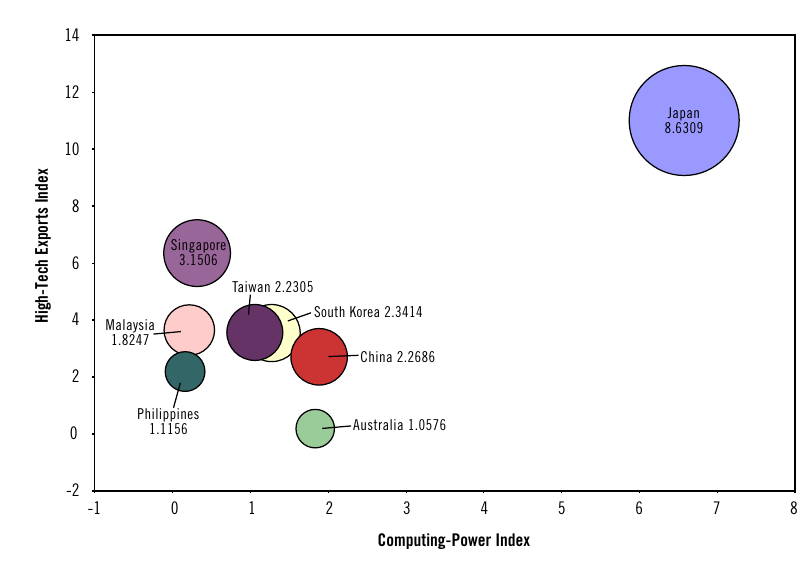
Figure 4 – Center Cluster: